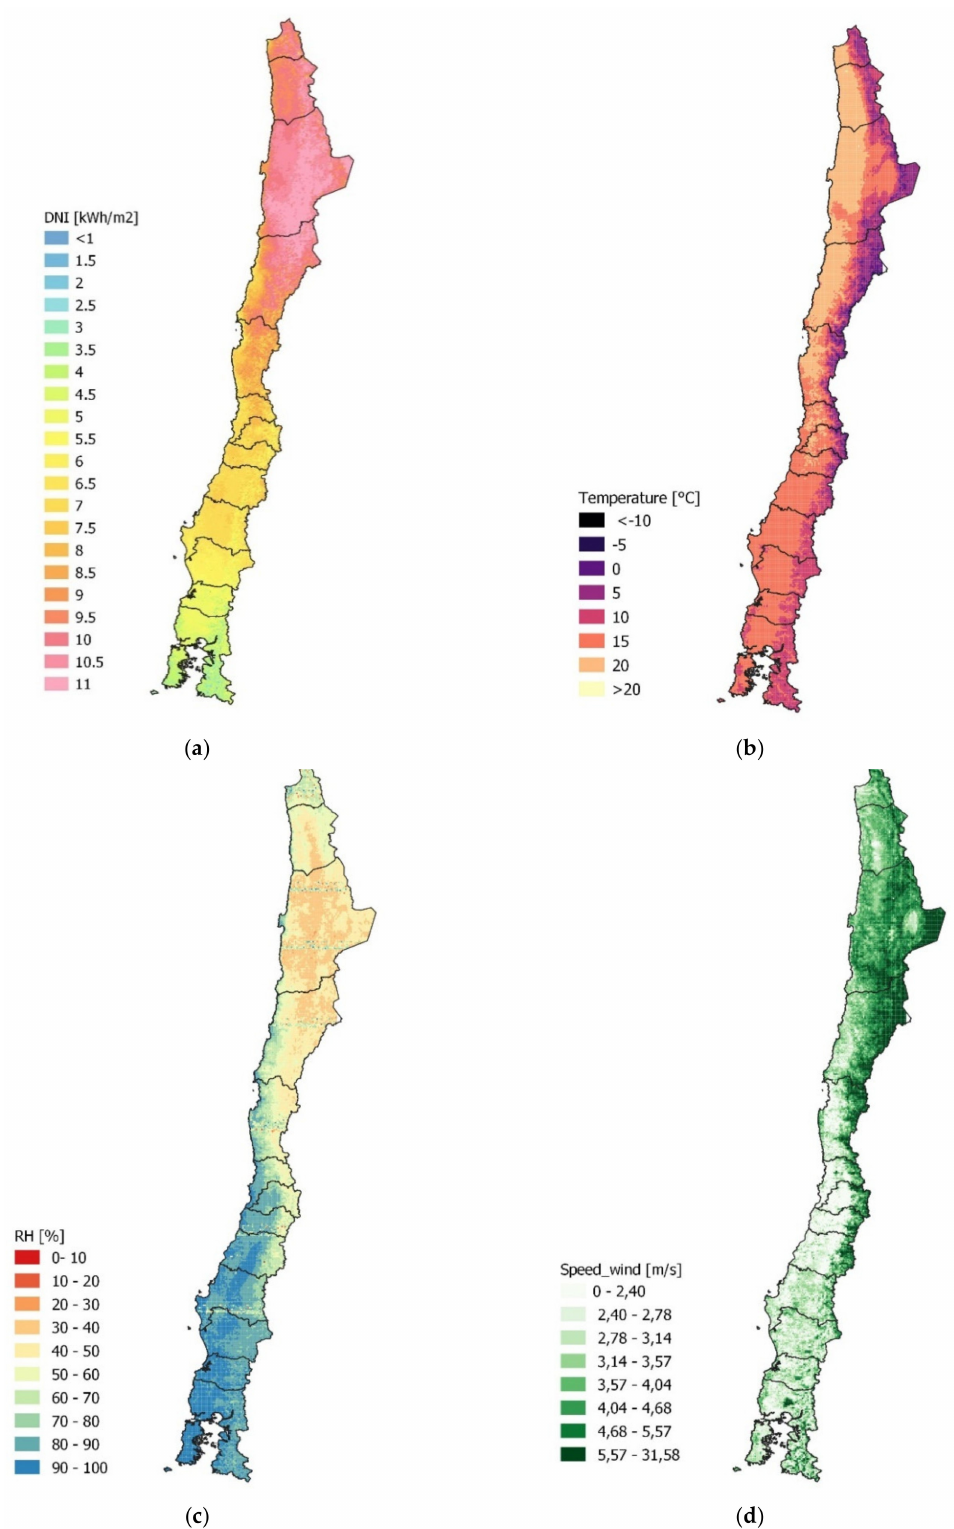
Figure 2. Average daily values of ( a ) direct normal irradiation (DNI) ( b ) ambient temperature ( c ) relative humidity ( d ) wind speed in Chile according to typical meteorological year (TMY) data, generated using the Solar Explorer